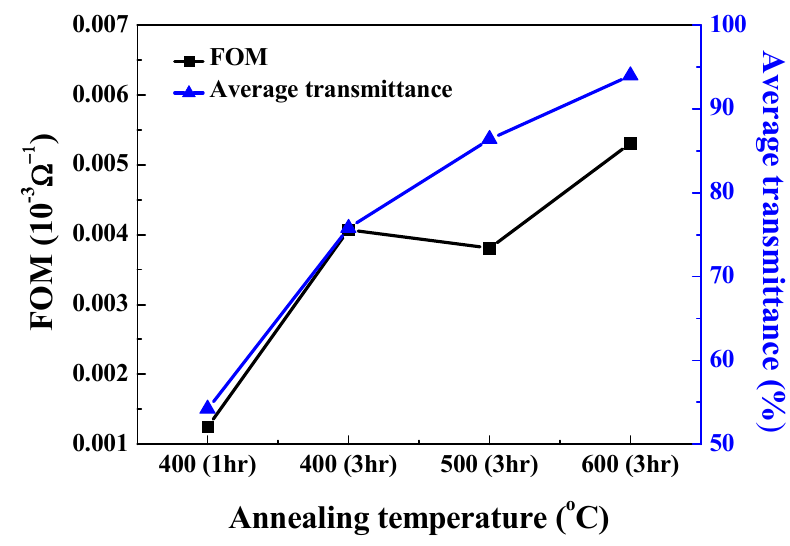
Figure 9. FOM values for L2NiO thin films as a function of annealing temperatures and time.